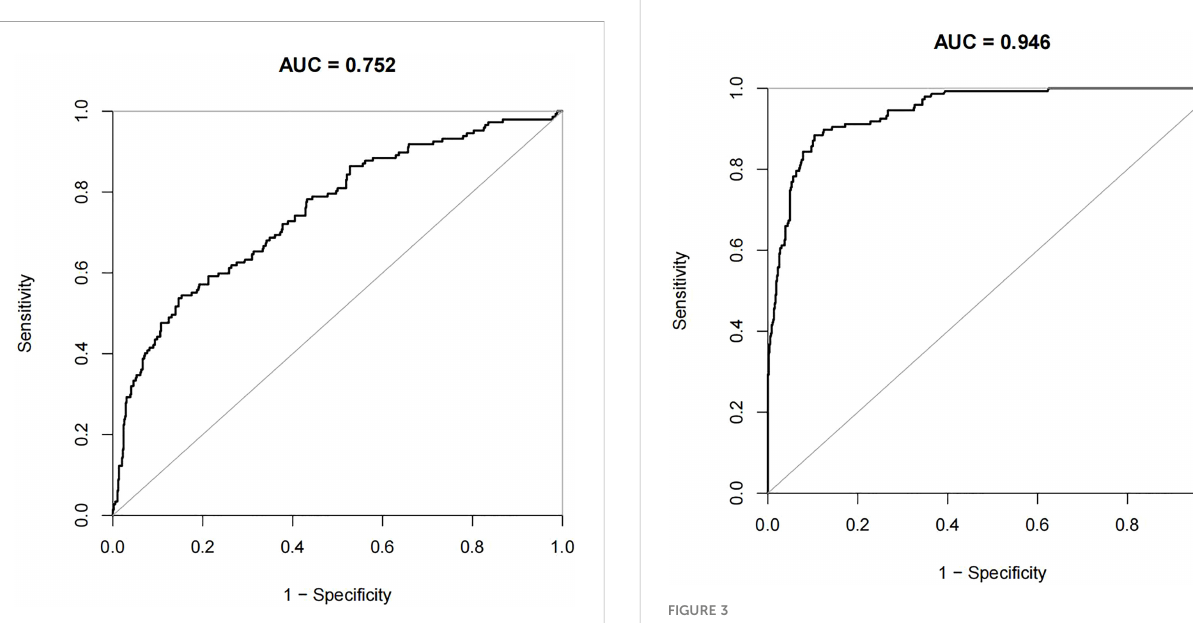
FIGURE 2 The AUC of the prediction model for GDM by stepwise LR. AUC, area under the receiver operating characteristic curve; GDM, gestational diabetes mellitus; LR, logistic regression.